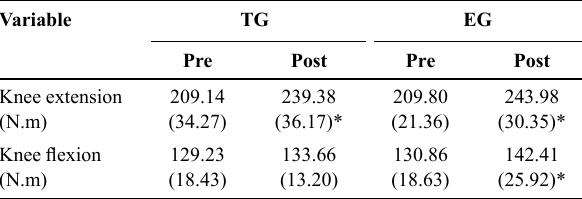
Table 2 - Mean and standard deviation values of the isokinetic torque peak.